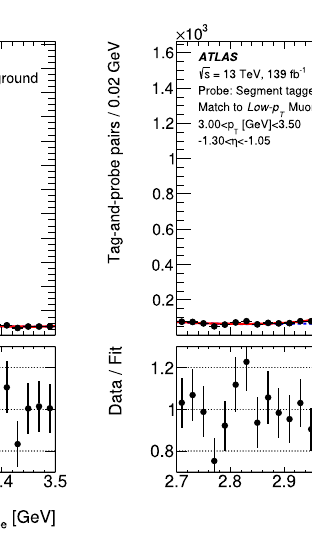
red line represents the total fitted signal plus the background contribu- tion. The panel beneath shows the data to fit-function ratio for each bin